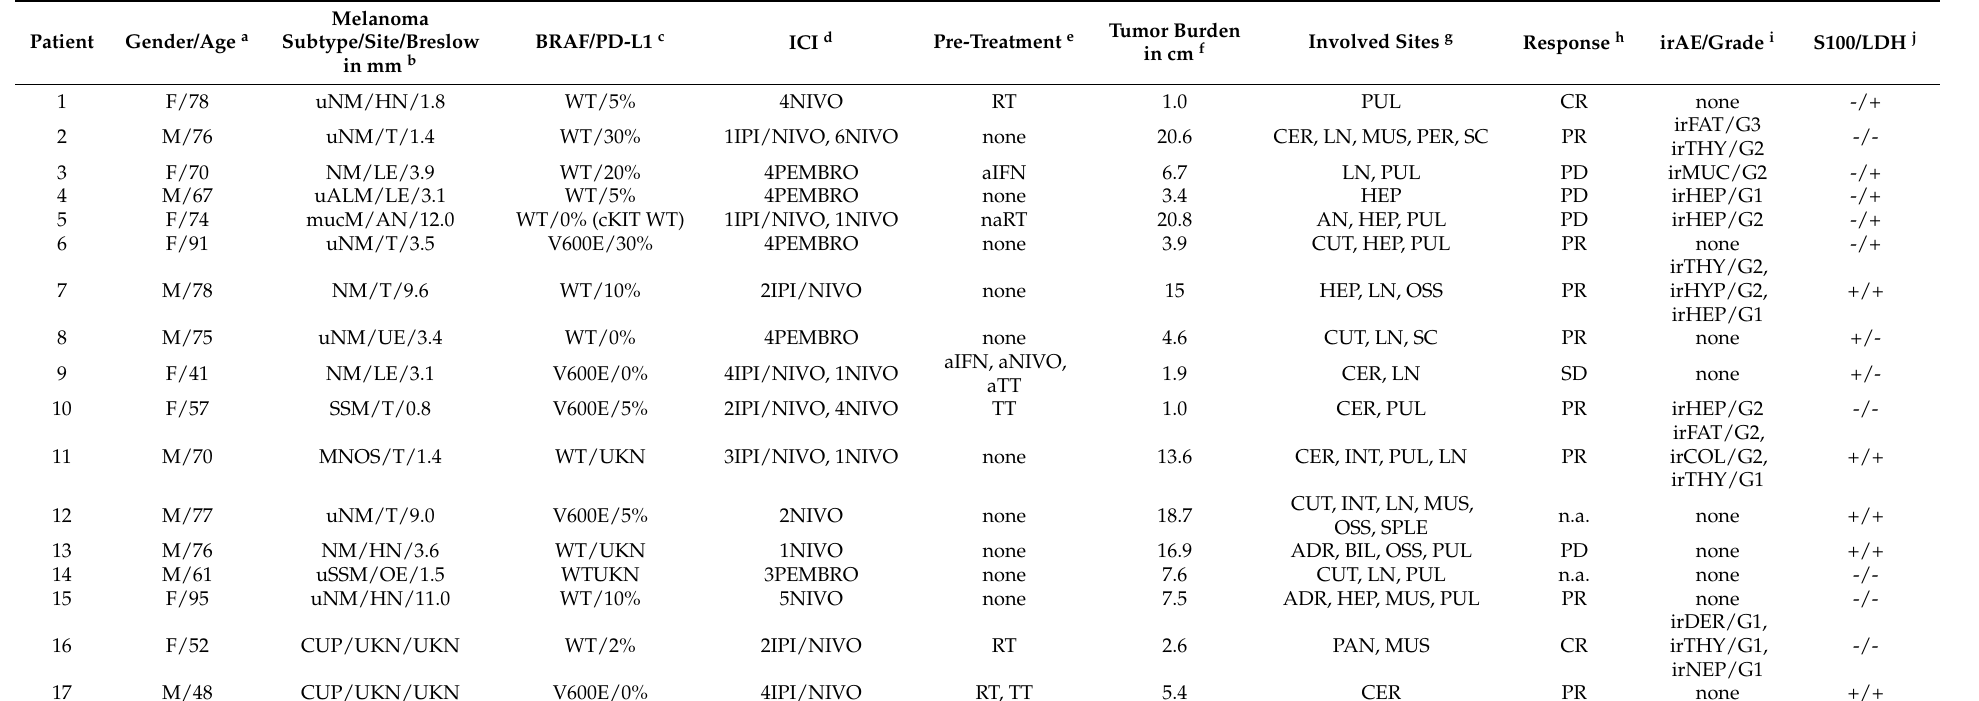
a gender female (F) or male (M). b melanoma subtype (ulcerated (u), nodular melanoma (NM), superficial spreading melanoma (SSM), acral lentiginous melanoma (ALM), mucosal melanoma (mucM), melanoma not otherwise specified (MNOS)), melanoma of unknown primary (CUP), site of primary (head and neck (HN), upper extremities (UE), torso (T), lower extremities (LE)), anal (AN), unknown site (UKN)/Breslow thickness in mm. c BRAF mutation (V600) or wild type (WT); PD-L1 positivity in percent of melanoma cells in immune histochemical staining vs. staining unknown (UKN). d number of treatment cycles during immune monitoring and therapy regimen of immune checkpoint inhibitors: nivolumab monotherapy (NIVO; 240 mg Q2W or 480 mg Q4W),ipilimumab/nivolumab combination therapy (IPI/NIVO; IPI 3 mg/kg bodyweight and NIVO 1 mg/kg bodyweight), pembrolizumab monotherapy (PEMBRO; 200 mg Q3W or 400 mg Q6W). e pre-treatment: adjuvant treatment (a), neoadjuvant (na,) targeted therapy with BRAF/MEK-inhibitors (TT), ICI (NIVO, PEMBRO), radiotherapy (RT), interferon- α (IFN). f tumor burden in cm (target + non-target lesions). g in metastasis involved sites: adrenal (ADR), anal (AN), gallbladder/bile (BIL), cerebral (CER), cutaneous (CUT), hepatic (HEP), intestinal (INT), lymph node (LN), muscular (MUS), skeletal (OSS), pancreatic (PAN), peritoneal (PER), pulmonary (PUL), subcutaneous (SC), splenic (SPLE). h complete response (CR, all target lesions (TL) and non-target lesions (NTL) regressed), partial response (PR, sum of diameters TL + NTL at least − 30%), progressive disease (PD, at least +20% in sum of diameters of TL + NTL), stable disease (SD, sum of diameters TL + NTL between − 29% and +19%); response not available (n.a.) due to early treatment change to TT or unknown cause of death before response evaluation. i immune-related adverse event (irAE) during immune monitoring and grade according to CTCAE v5.0 (G1-5): irHepatitis (irHEP), irFatigue (irFAT; irFAT grade 1 was not assessed as irAE), irGamma-glutamyltransferasis elevated (irGGT), irThyroiditis (irTHY), ir lichenoid mucositis (irMUC), irHypophysitis (irHYP), irNephritis (irNEP). j S100 and LDH above upper level of normal (+) vs. normal values (-) at start of